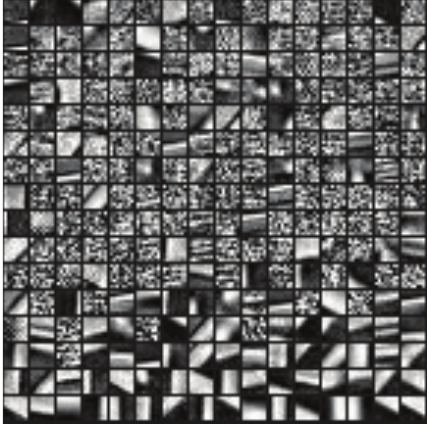
Figure 9: The PCDDL dictionary has a size of 64 × 256, which was learned from the noisy House image in Figure